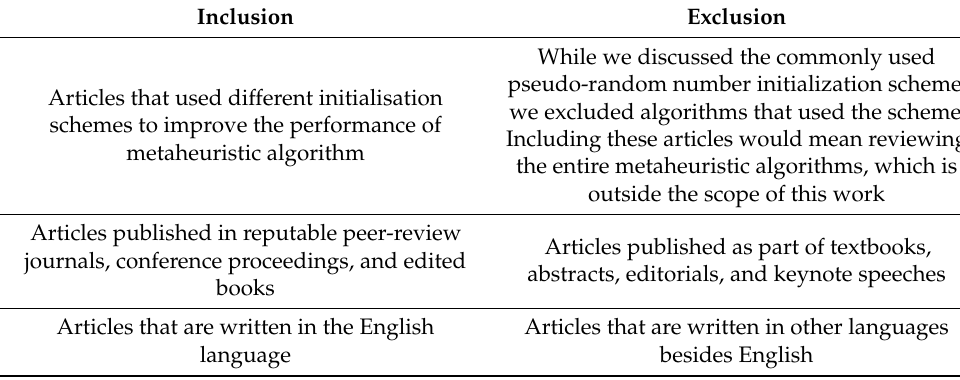
Table 1. Inclusion/Exclusion Criteria.